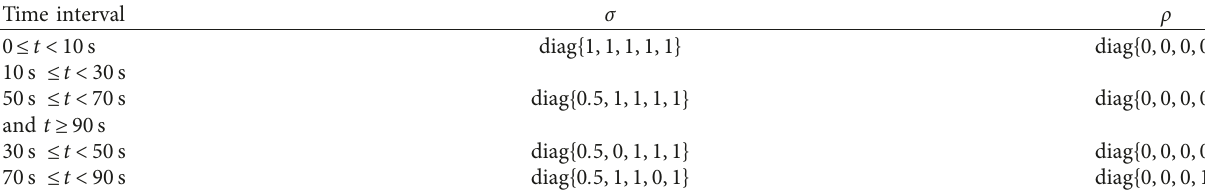
Table 1: Fault indication matrices σ and ρ